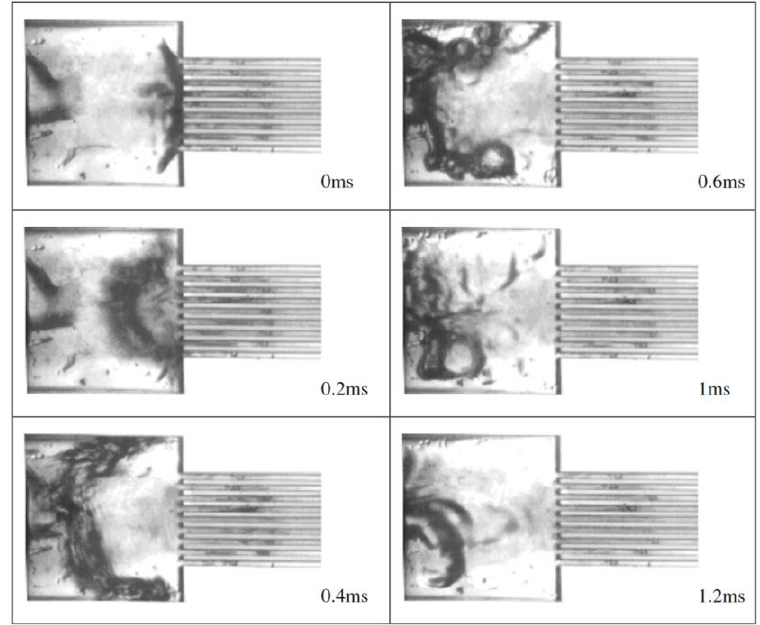
Figure 7. Explosive boiling phenomena [20].